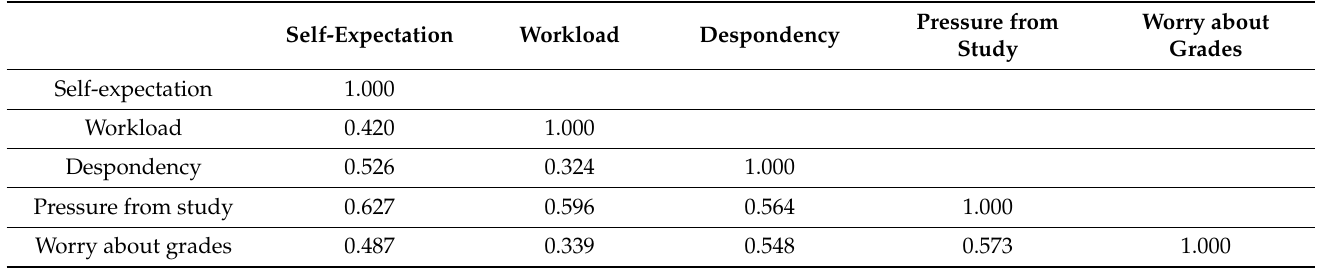
Table 5. Correlations (Spearman’s rho) between ESSA subscales (N = 399).